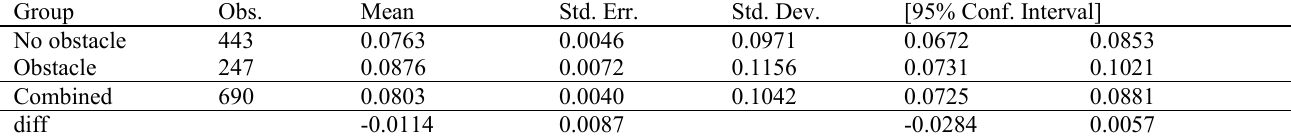
Table 1: Performance of firms reporting finance as obstacle vs. those not Panel A: Employment growth Two-sample t test with unequal